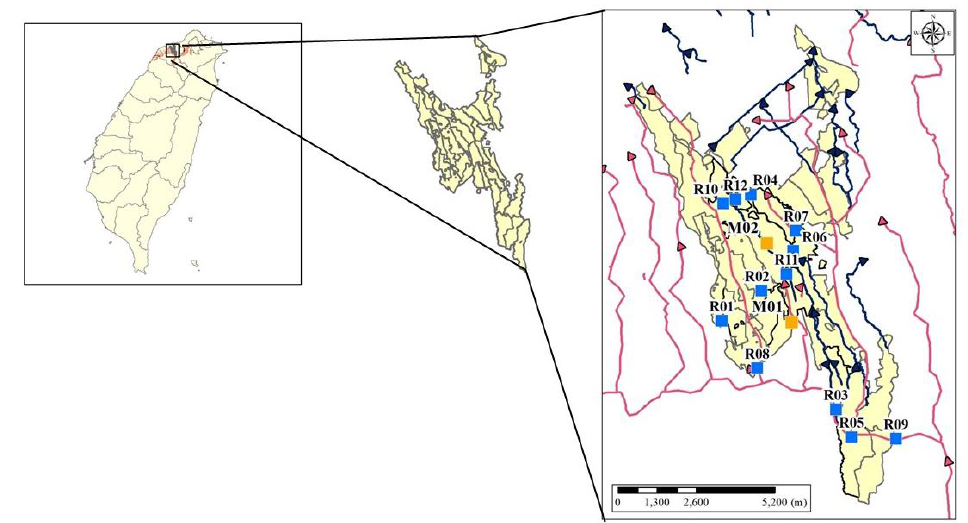
Figure 3. Taoyuan irrigation district study area. Note: Blue boxes represent regular water monitoring stations, and orange boxes represent heavy metal monitoring stations.